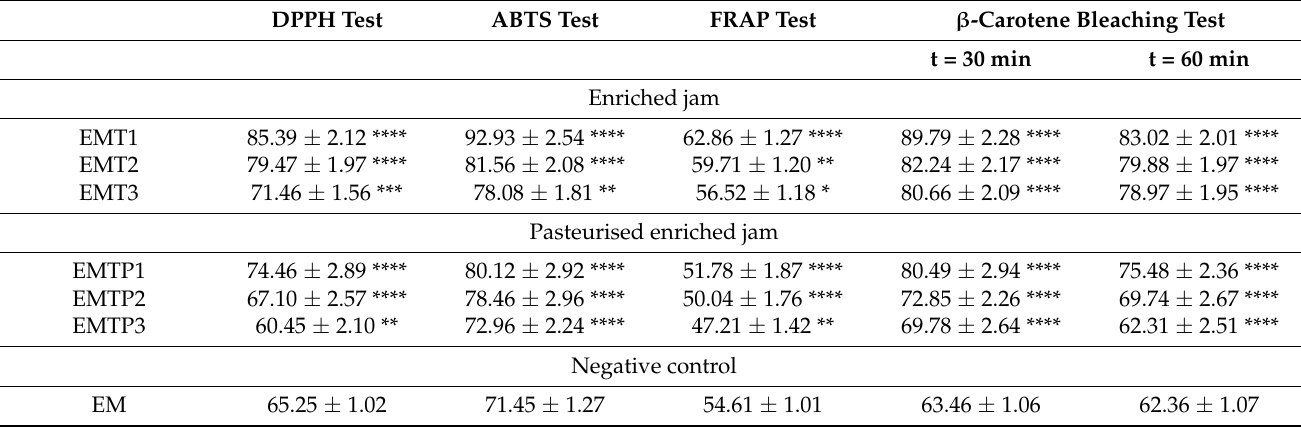
Table 7. Antioxidant activity (%) of enriched and pasteurised enriched